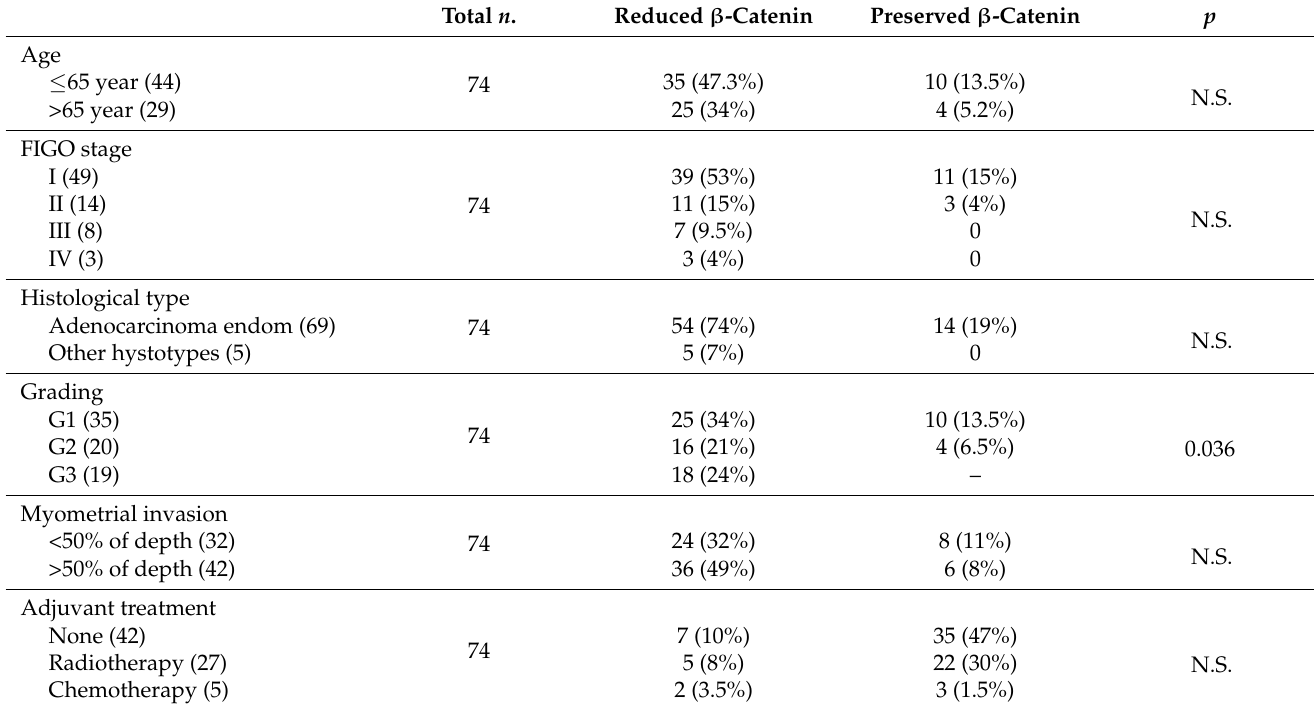
Table 2. Distribution of β -catenin membrane expression levels according to patient characteristics. Total n